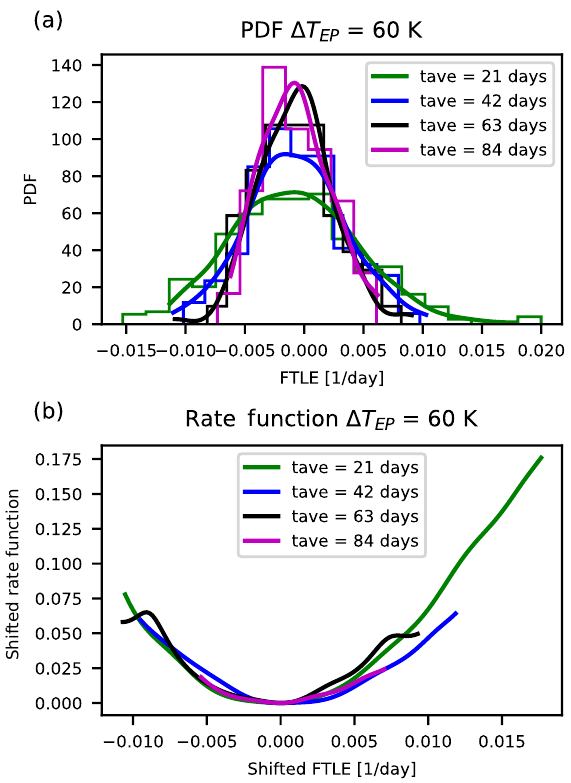
Figure 9. Distributions and rate functions of λ 71 a near-zero, de- caying instability in PUMA, for (cid:49)T EP = 60K. Panels as in Fig. 2.